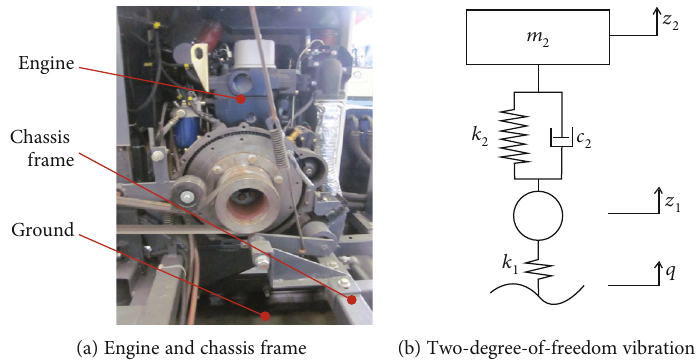
Figure 2: Schematic diagram of the vibration model of the chassis frame and